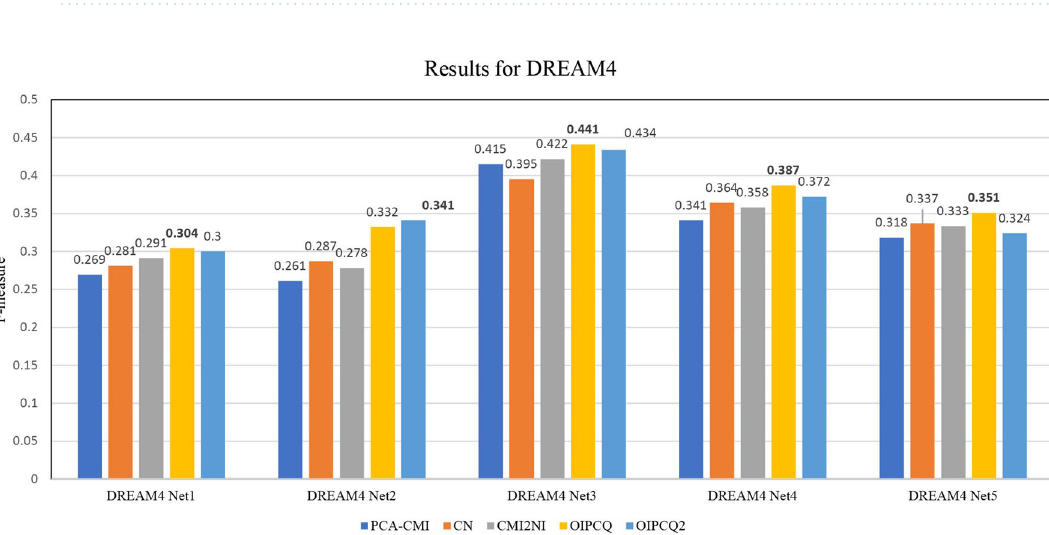
Table 4. Results for different orders of OIPCQ2 algorithm for DREAM3-Yeast1 of size10, 50 and 100. Best results are indicated in bold.